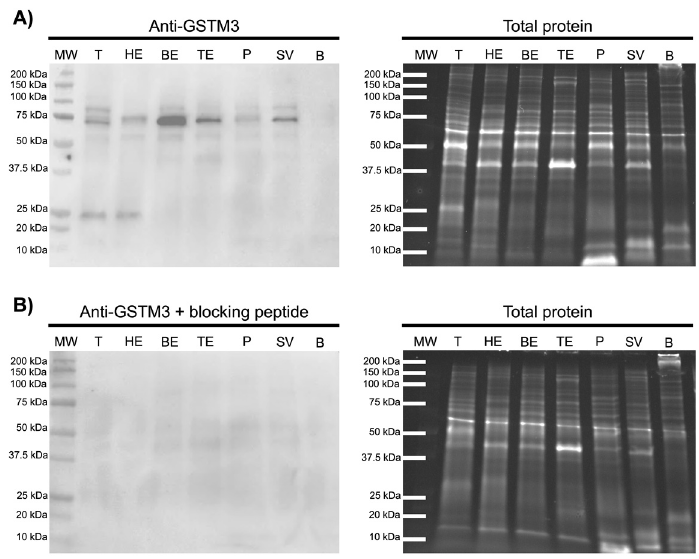
Figure 4. Representative Western blot resulting from incubation with the ( A ) GSTM3 antibody (Anti-GSTM3), ( B ) its corresponding peptide competition assay (Anti-GSTM3 + blocking peptide) and their loading controls (Total protein). MW: molecular weight. T: testis. HE: caput epididymis. BE: corpus epididymis. TE: cauda epididymis. P: prostate. SV: seminal vesicles. B: bulbourethral glands.